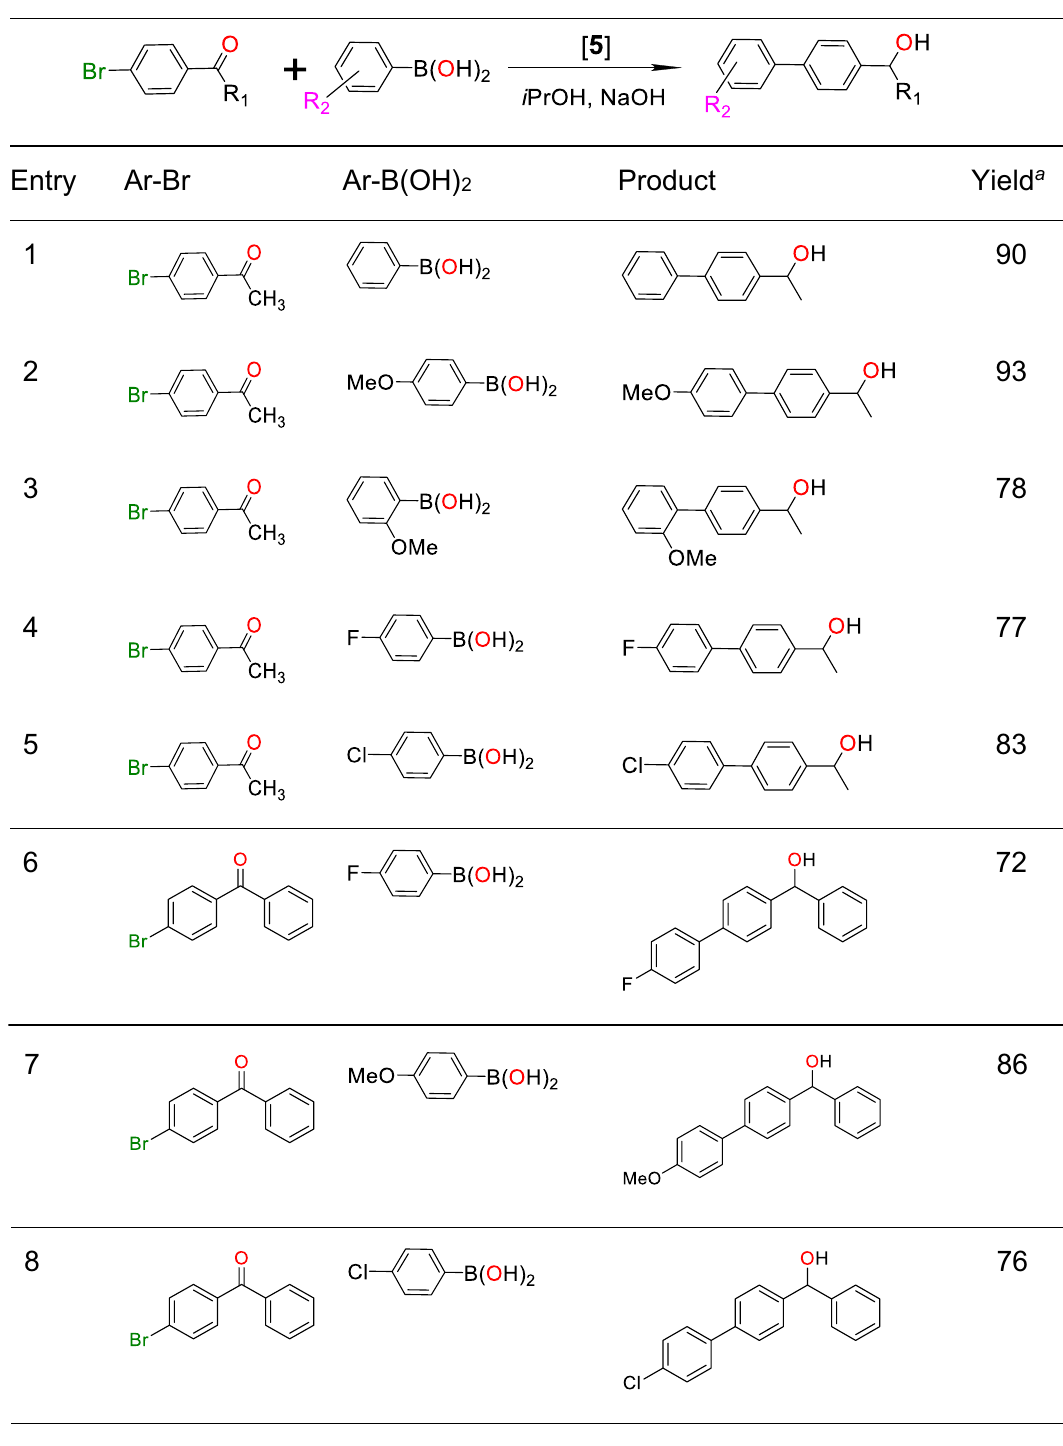
Table 2. Tandem Suzuki coupling/transfer hydrogenation of 4-bromoacetophenone. Reaction condition: